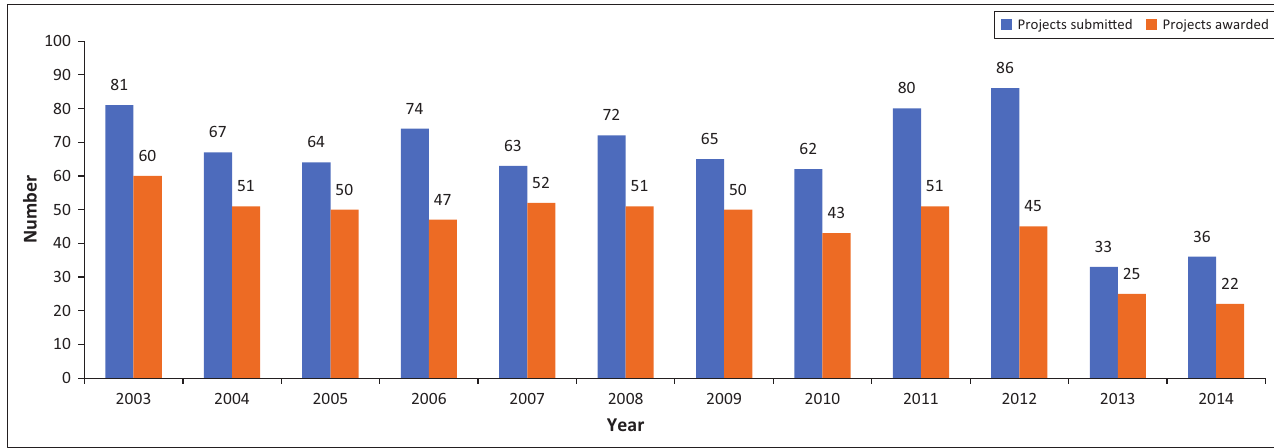
FIGURE 2 : Kaohsiung municipal administration innovation proposal results (2016).